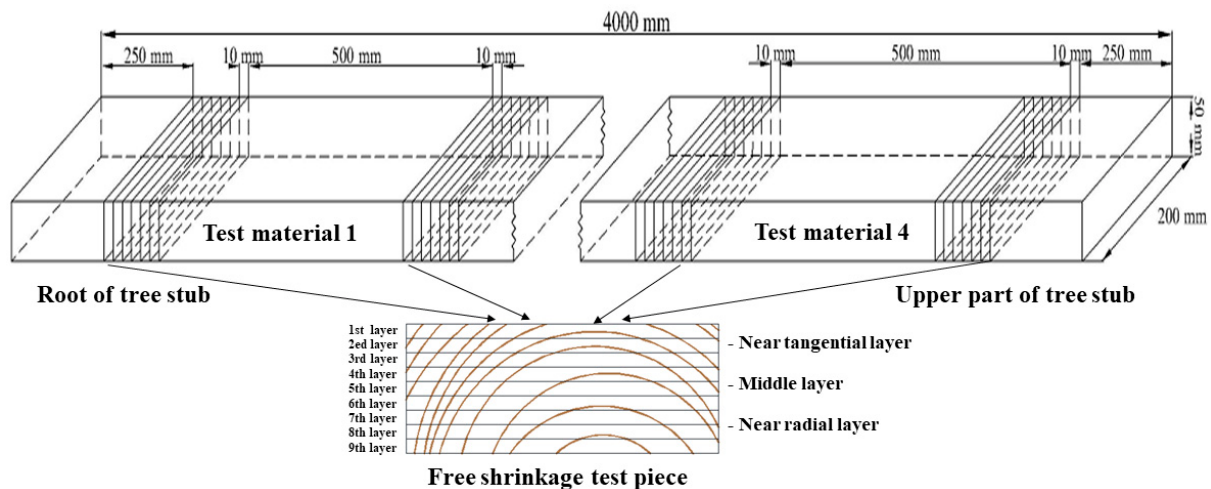
Figure 1. Preparation of specimens used to study the free and actual drying shrinkage laws of Mongolian Scotch pine sawn timber. Table 1. Drying conditions of test strips used for free drying shrinkage performance tests.